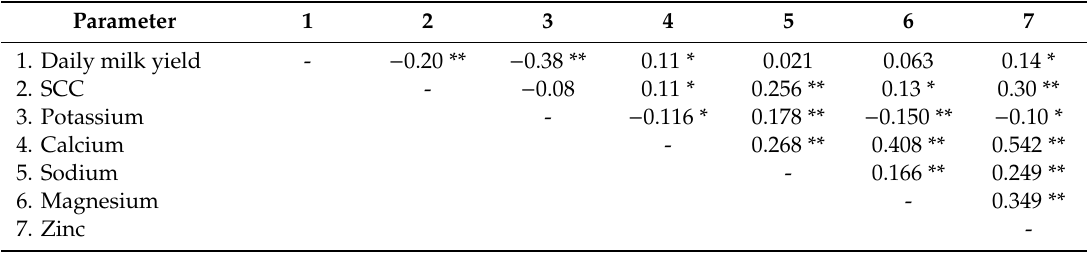
Table 3. Correlations between milk